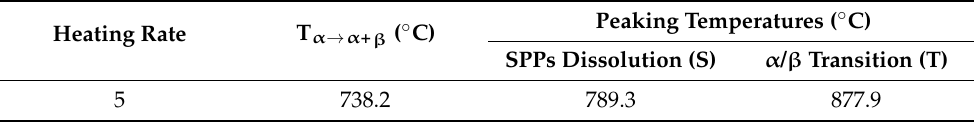
Table 2. α to α + β transition temperature and Peaking values of N36 zirconium alloy obtained by DSC measurement.